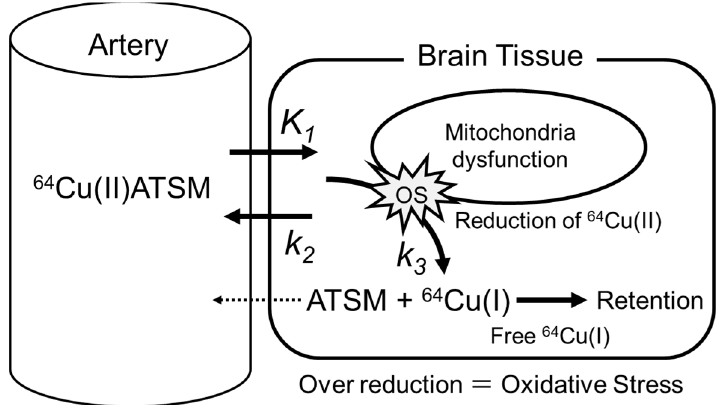
Figure 1. Kinetic model of 64 Cu-ATSM. 64 Cu(II) is reduced to 64 Cu(I) and irreversibly dissociated from ATSM chelate. Therefore, the 1-tissue compartment 3-parameter model represents the tracer kinetics well.